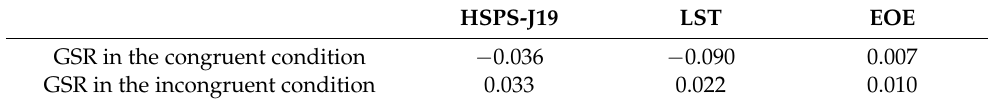
Table 2. Correlation between HSPS-J19 and maximum rate of GSR